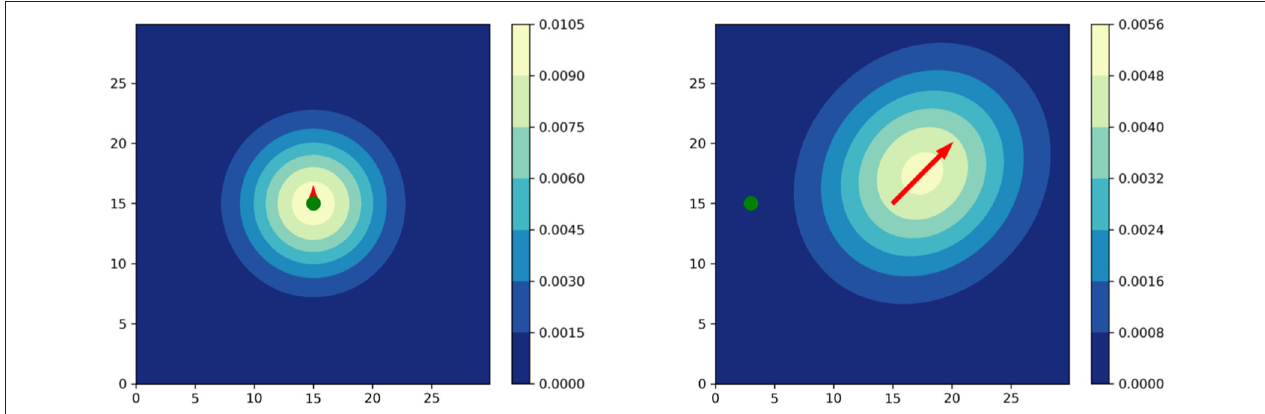
FIGURE 1 | Player influence models according to Fernandez and Bornn (2018). The ball is visualized in green. (Left) Player standing with the ball. (Right) Player moving away from the